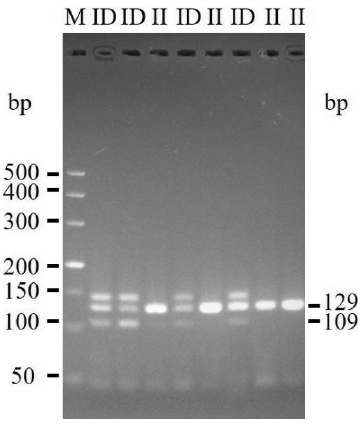
Figure 1. Genotyping of the 20-bp indel determined by PCR am- plification product size (3.5% agarose gel) using P1